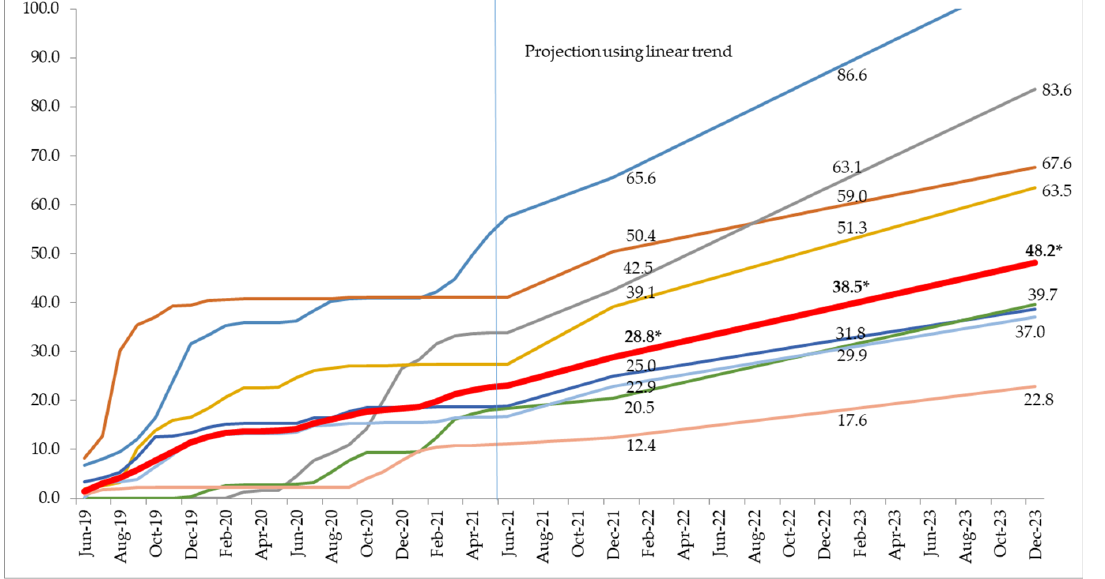
Figure 2. The monthly trend in the cumulative percentage of the total population registered during June 2019 to June 2021 and the linear forecast for December 2021, 2022, and 2023 in the eight selected PMCIs supported by the PSSP in Sri Lanka. Note: Each line represents a PMCI and the dark red line is the aggregate of all the eight PMCIs. The cumulative percentage is calculated for a month with the total number of individuals registered until the last day of the month from June 2019 and the total population in the PMCI as the denominator. * This is derived by aggregating numerator and denominator from the eight selected PMCIs. The data labels are mentioned for December 2021, December 2022, and December 2023.